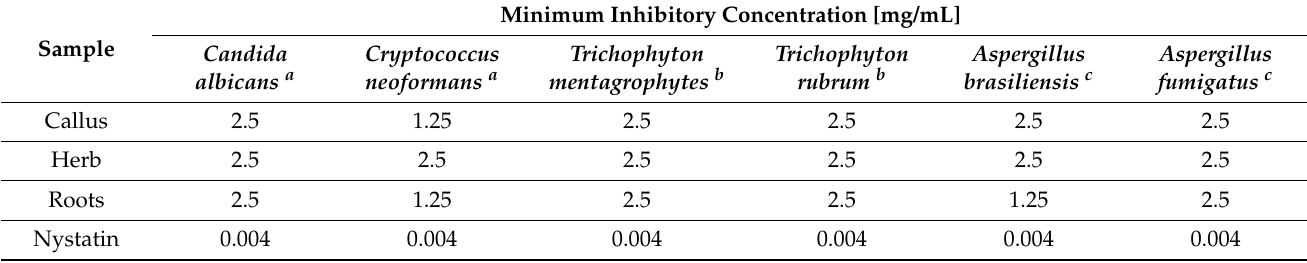
Table 2. Minimum inhibitory concentration (MIC, mg/mL) values of methanolic extracts from the callus, flowering herb, and roots of micropropagated Lychnis flos-cuculi tested against pathogenic fungi. Nystatin was used as a positive control.